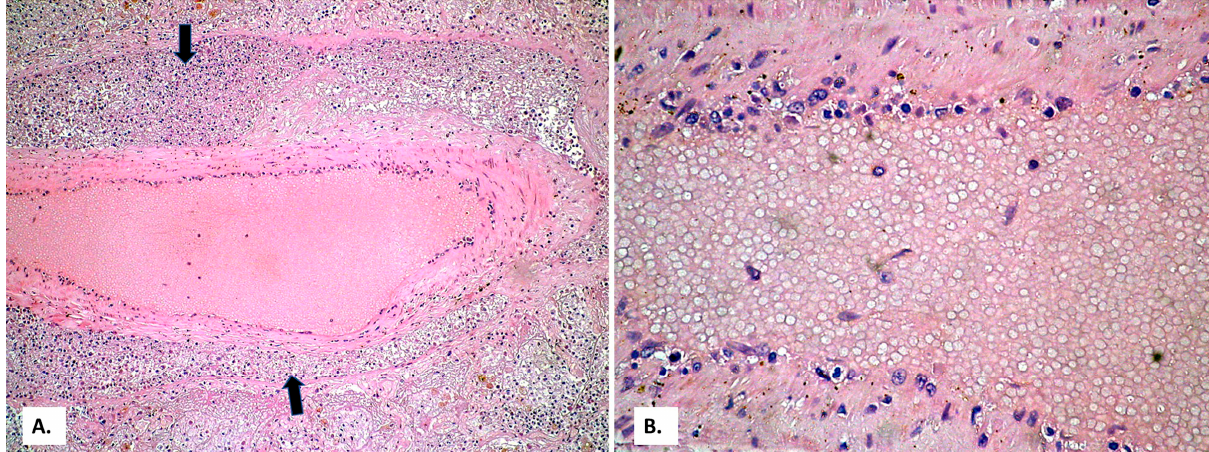
Figure 4. ( A ) Thrombosed arterial vessel, dilated perivascular lymphatics (arrows) filled with a cell-rich lymph fluid (HE